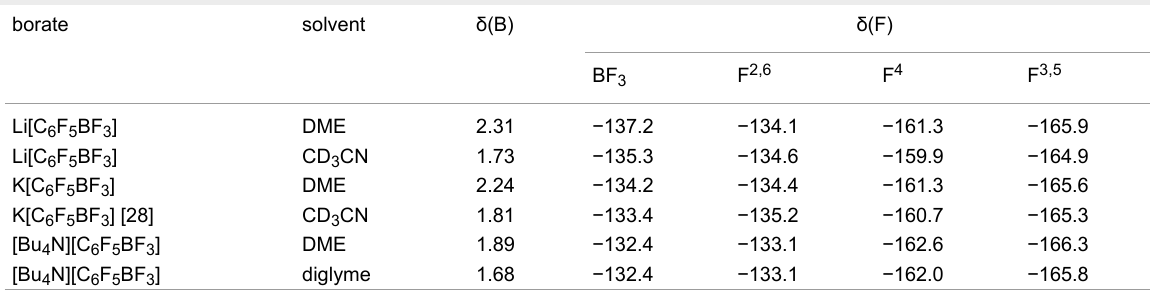
Table 4: The 11 B and 19 F NMR spectra of M[C 6 F 5 BF 3 ] a . borate solvent δ